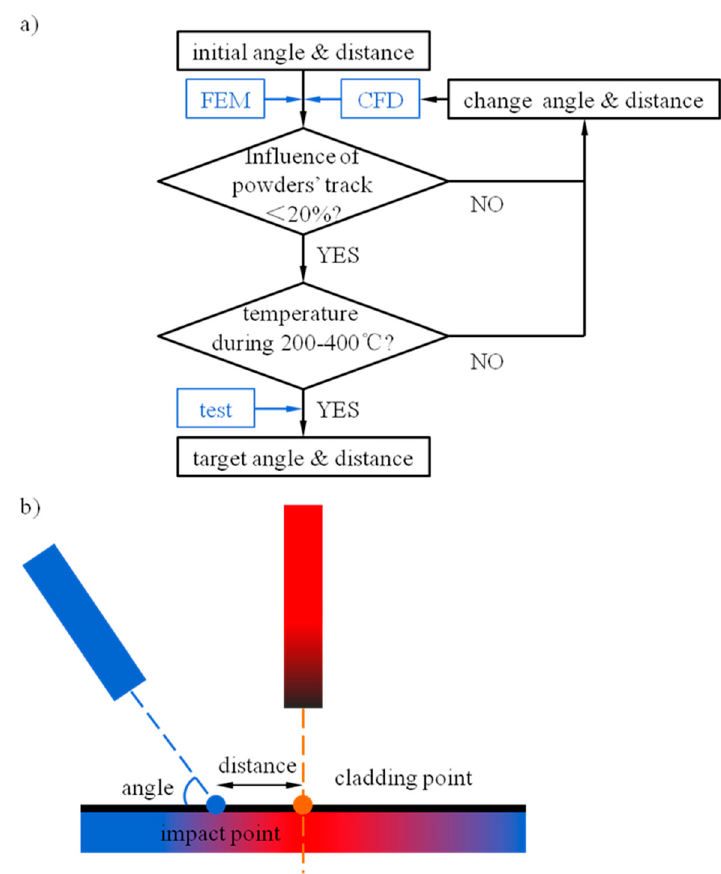
Figure 1. The calculation scheme and schematic diagram of the hybrid process. ( a ) The calculation scheme and ( b ) schematic diagram of the hybrid process.